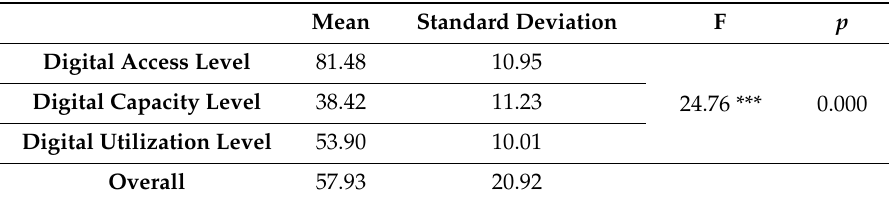
Table 10. Summary of digital divide of older